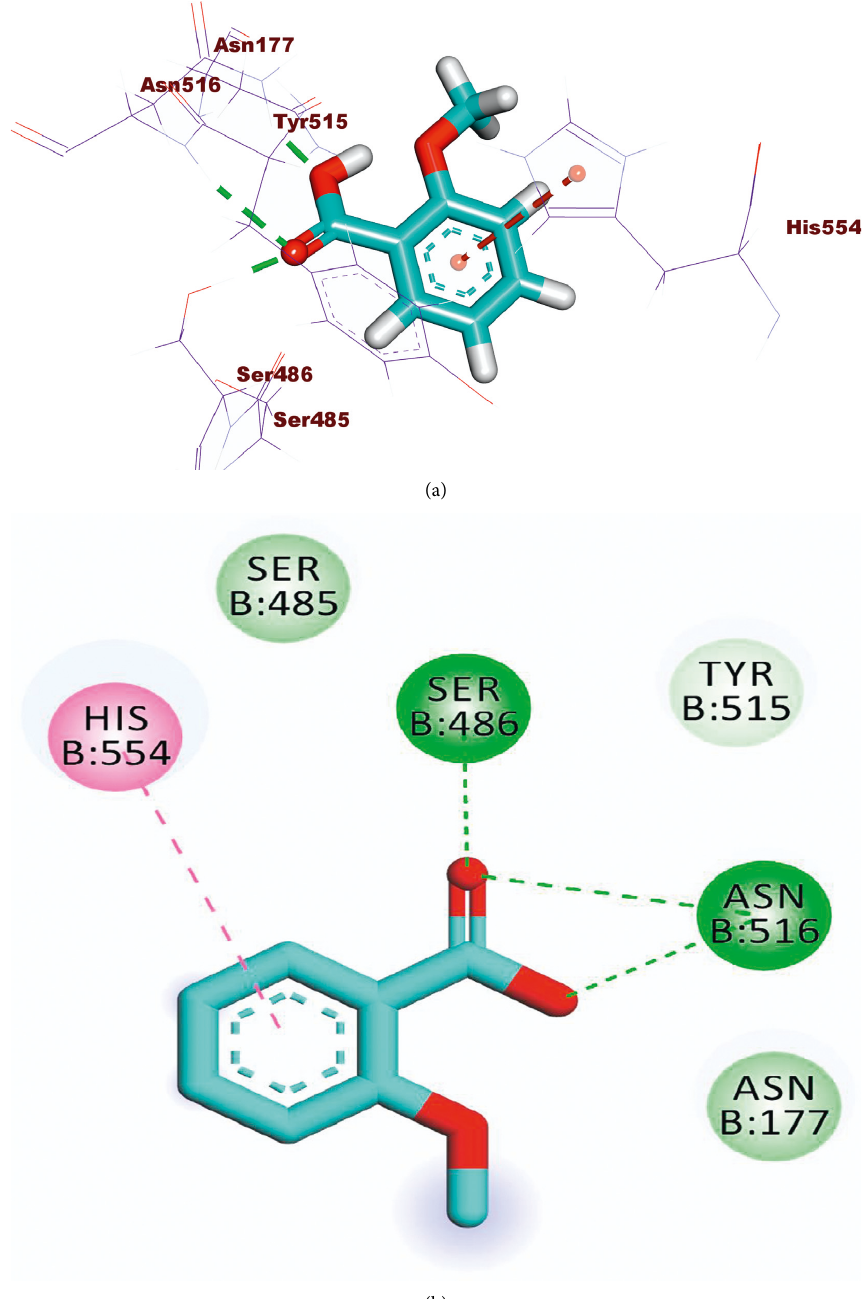
Figure 10: (a) 3D and (b) 2D images of docked compound 364 into the active site of SARS-CoV-2